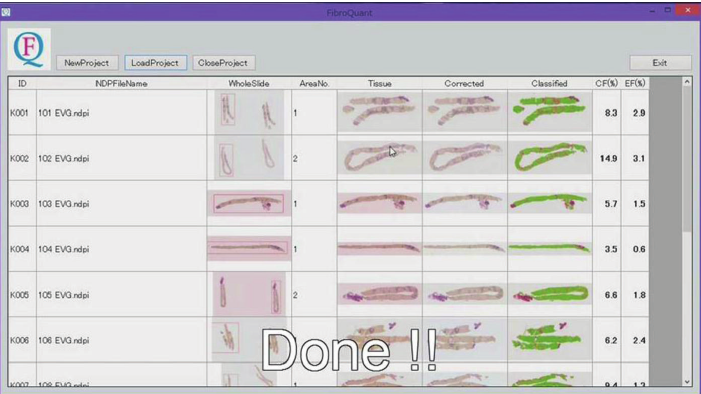
Figure 1: Whole slide image analysis system for quantification of liver fibrosis. The figure shows the color corrected and classified WSI and the area ratios of collagen and elastic fibers obtained by the